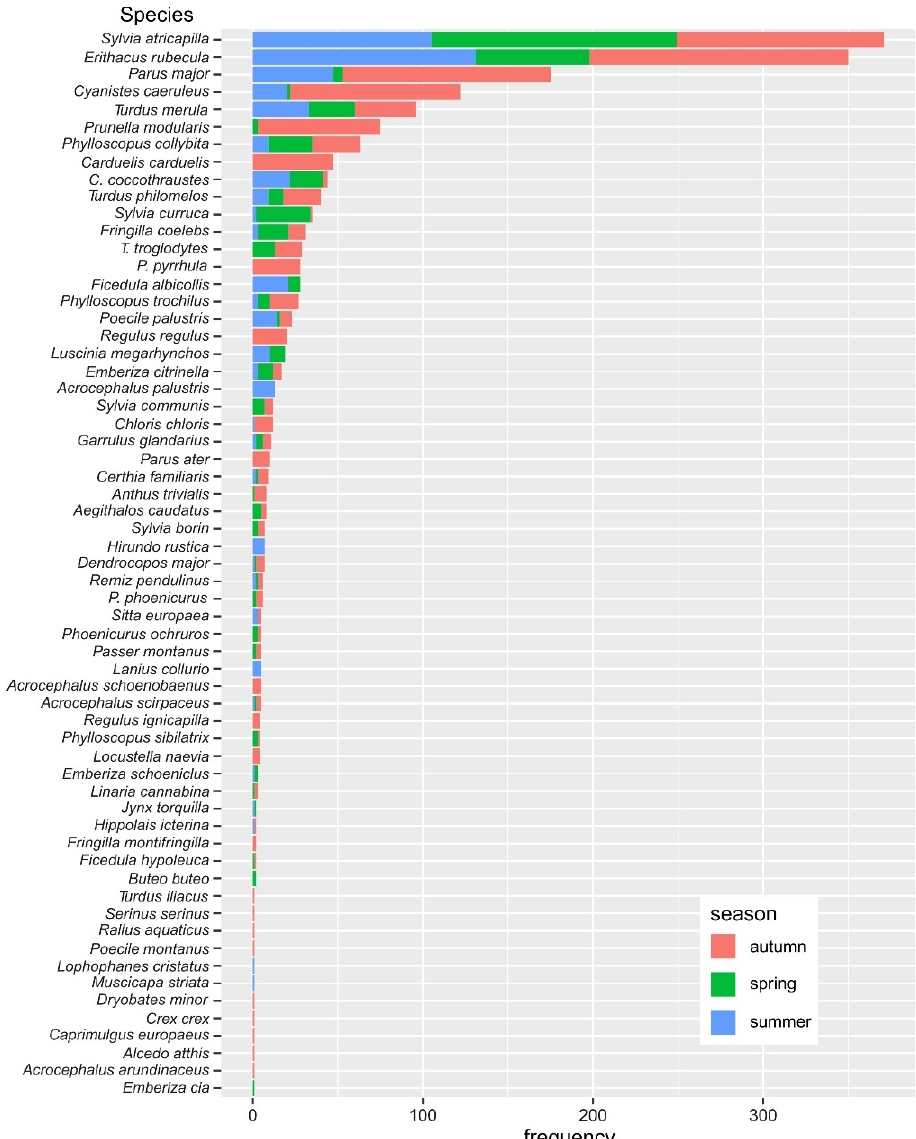
Figure 1. Sampling rates for avian species captured in Drienovec, Slovakia, during 2017, 2018 and 2019.